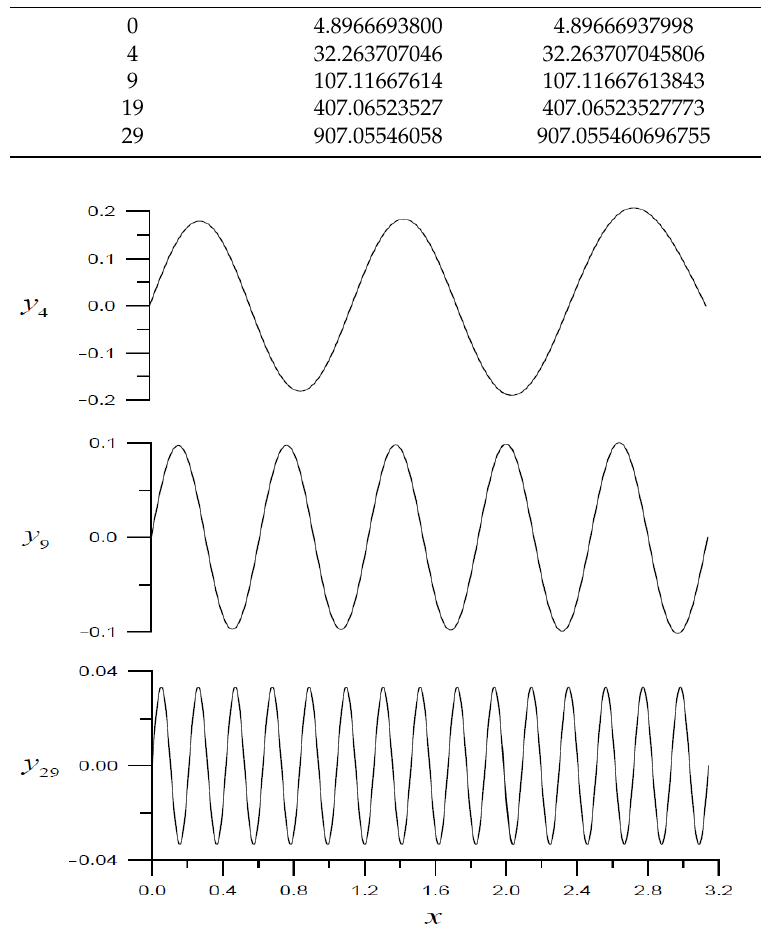
Figure 4. Numerical solutions of the eigenfunctions for Example